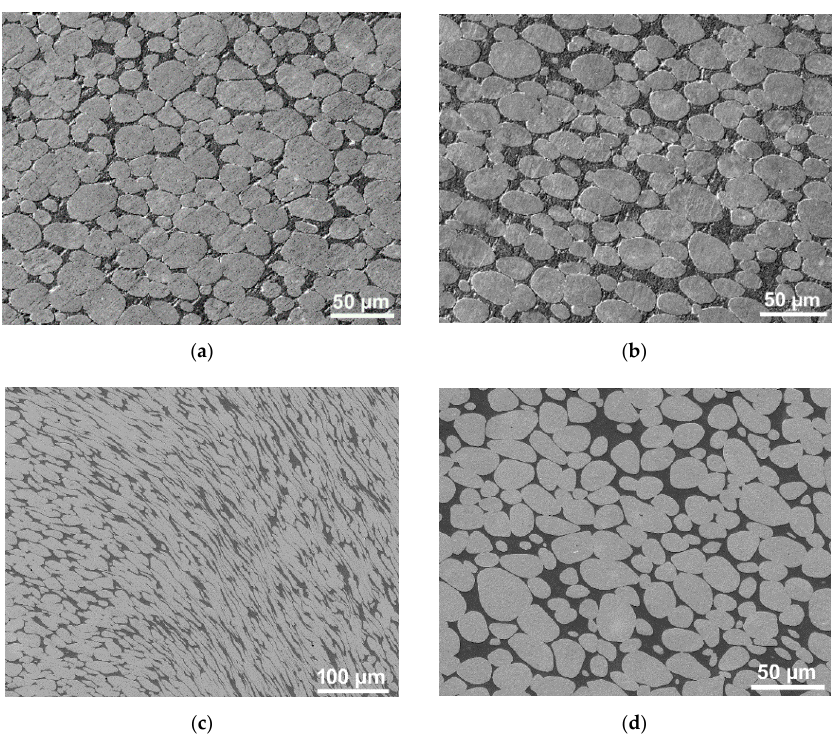
Figure 10. SEM-SE images of 900 °C swaged piece subsurface region ( a ), 900 °C swaged piece axial region ( b ), 1100 °C swaged piece subsurface region ( c ), 1100 °C swaged piece axial region ( d ).